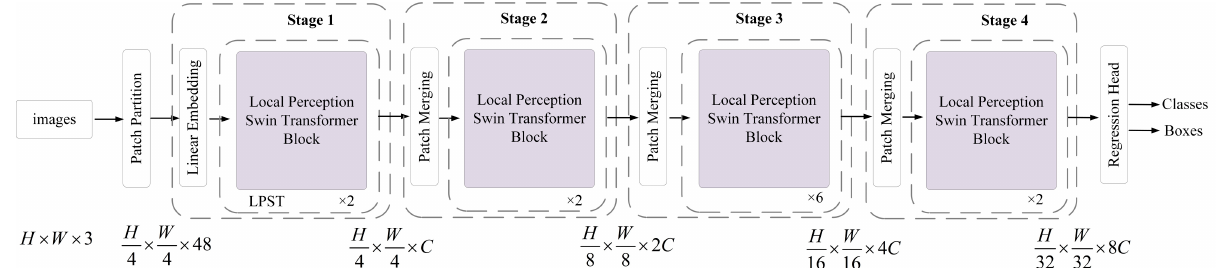
Figure 4. The architecture of the pedestrian and vehicle detection network.